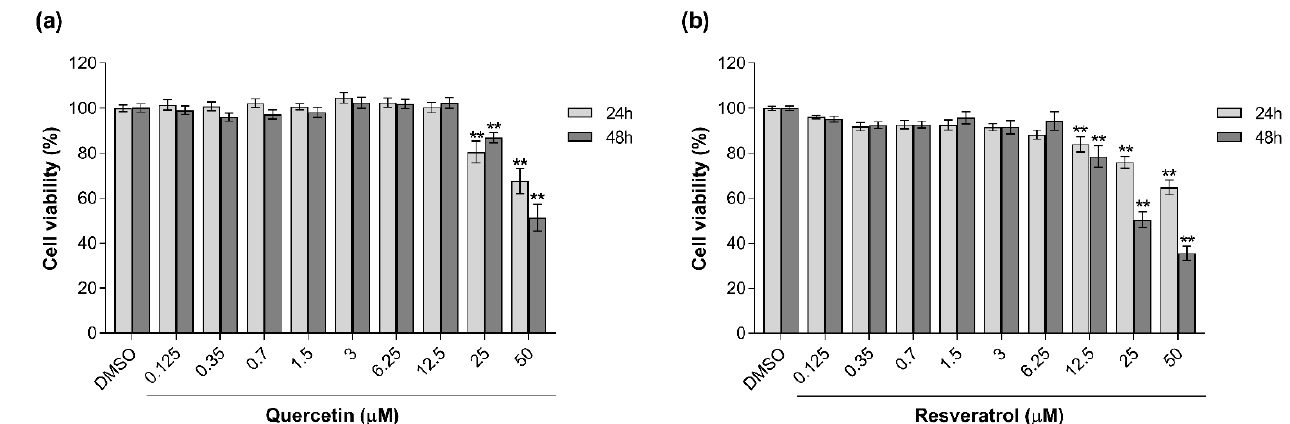
Figure 1. Effects of Q (0.12–50 µ M) ( a ) and R (0.12–50 µ M) ( b ) on CRFK cell viability after 24 and 48 h exposure measured with the NRU assays. Results are expressed as a percentage of viability compared with the solvent control (0.1% DMSO). Data are represented as mean ± SEM of three independent experiments and analyzed by one-way ANOVA followed by Dunnett’s test. Statistical differences with respect to the controls are indicated (** p < 0.01).